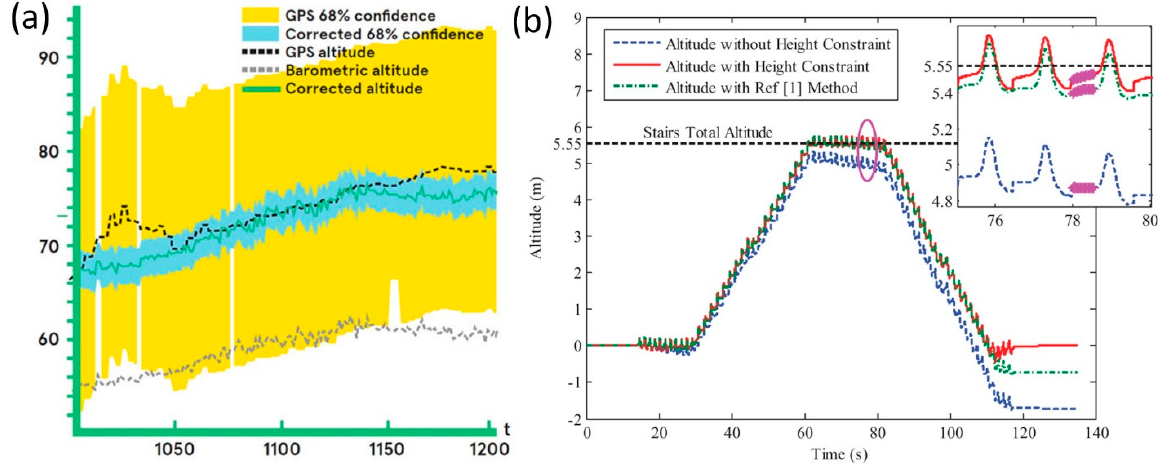
Figure 6. ( a ) Confidence bounds or GPS, barometric and fused altitude measurements. Reprinted/adapted with permission from Ref. [57]. Copyright 2014, IEEE. ( b ) Altitude curves calculated by different methods/algorithms from a pedestrian navigation-based MEMS pressure sensor and its error correction algorithm. Reprinted/adapted with permission from Ref. [58]. Copyright 2017, Emerald Publishing.